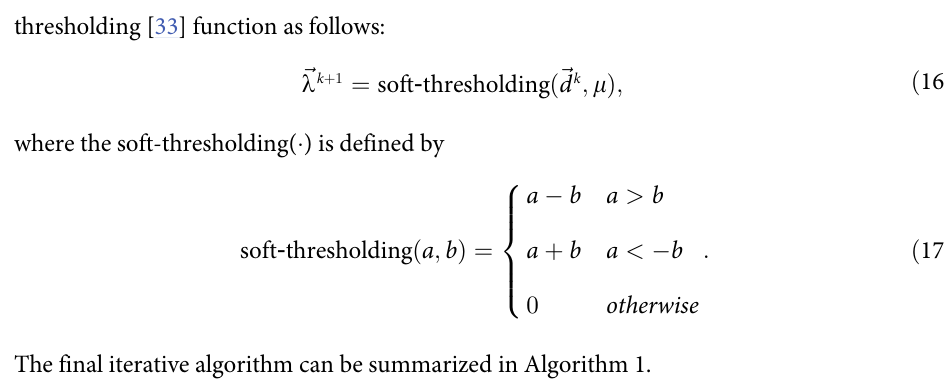
-ring algorithm. 1